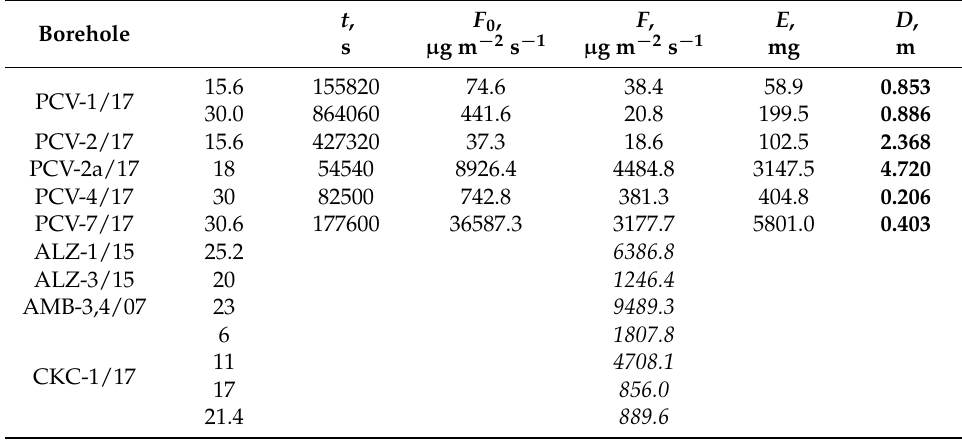
Figure 6. Scatter plot of the initial concentration C b of methane in borehole and the average flux from borehole F : linear relationship and its equation.